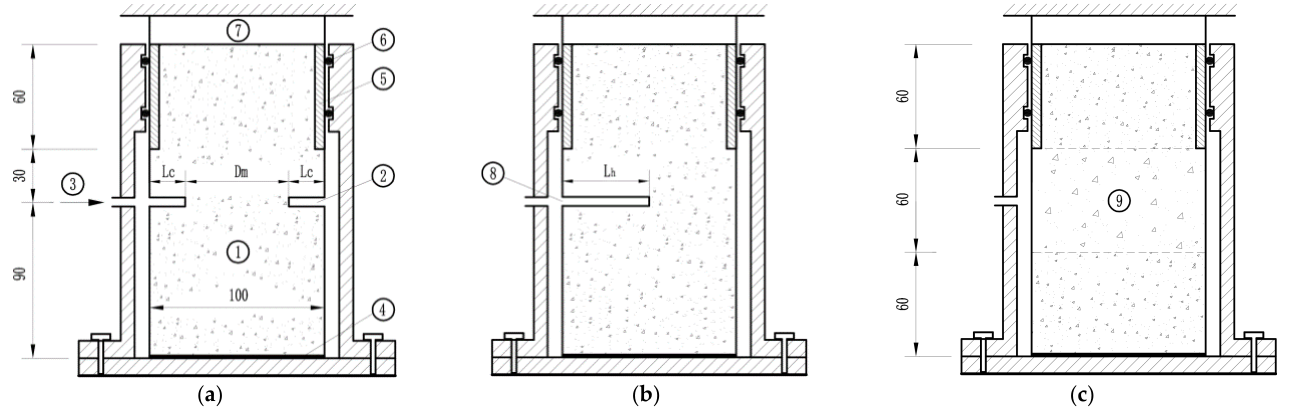
Figure 1. Model tests for the asphalt specimen with ( a ) ring crack, ( b ) semicircle crack, and ( c ) air porosity of 8.0% under vertical displacement restraint conditions: ① asphalt specimen; ② ring crack; ③ pressure water; ④ glue binding; ⑤ steel sleeve; ⑥ rubber ring; ⑦ force sensor; ⑧ semicircle crack; ⑨ middle layer with large air porosity.